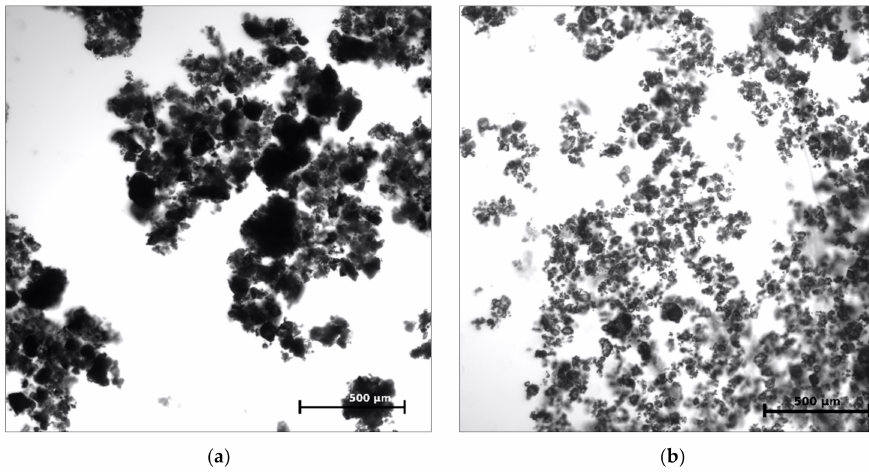
Figure 9. Microscope pictures of cement suspension: ( a ) CEM 42.5 R; ( b ) CEM 52.5 R.